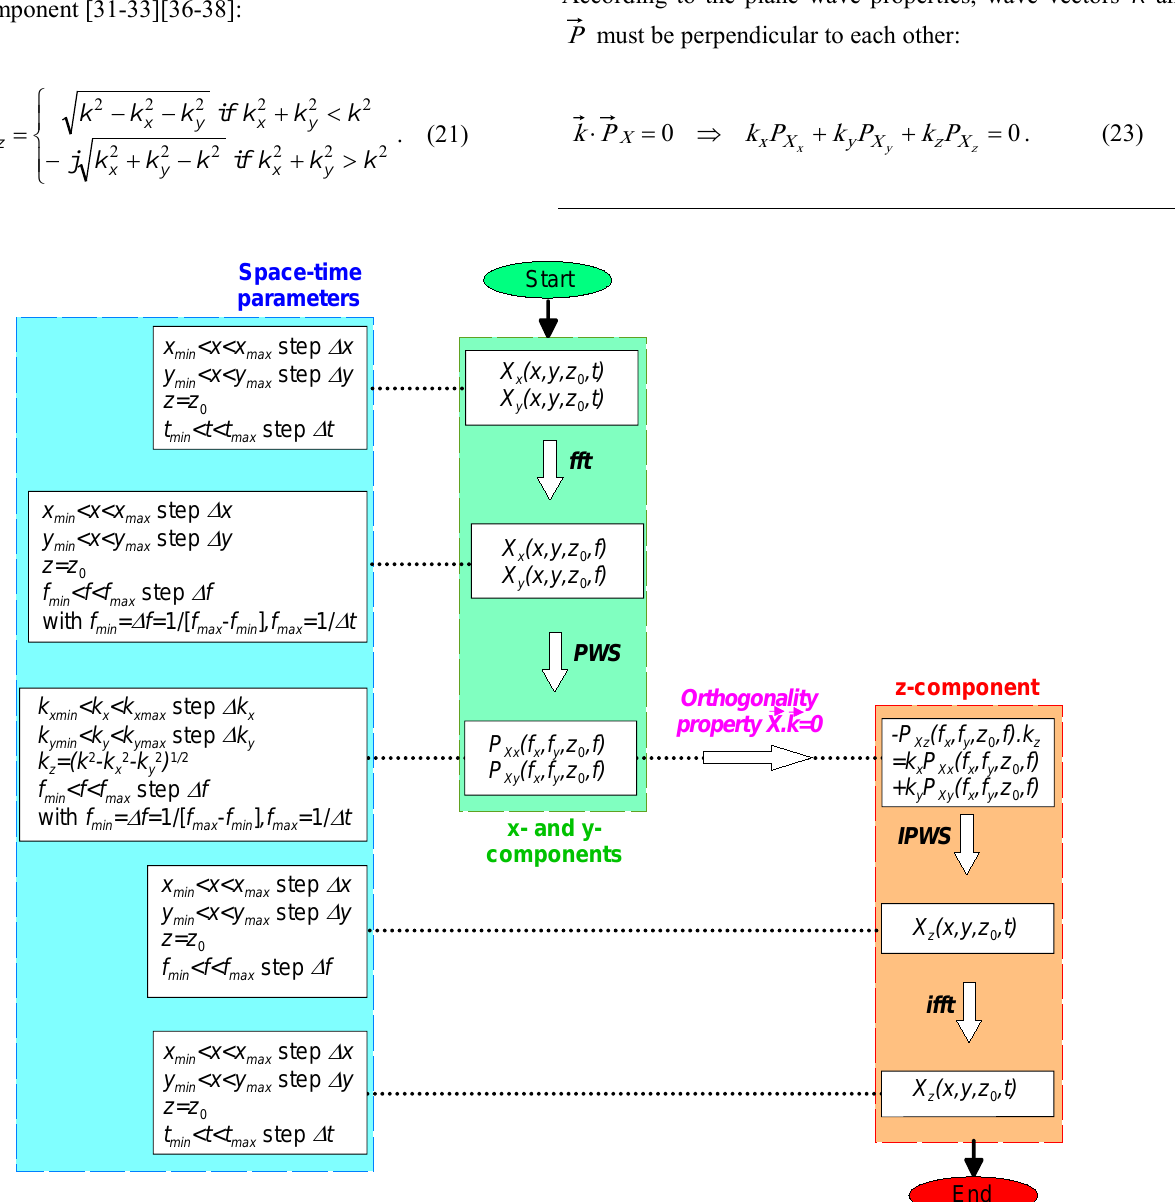
Figure 13: Routine algorithm illustrating the computation method of X z from X x and X y by using the PWS